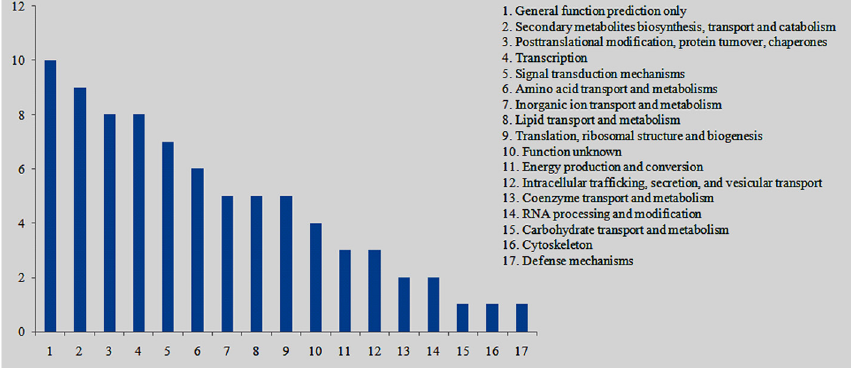
Fig 8. KOG function classification of the genes expressed specifically or preferentially in the selfed ovules of Xanthoceras sorbifolium . The X-axis indicates KOG function classification. The Y-axis indicates number of